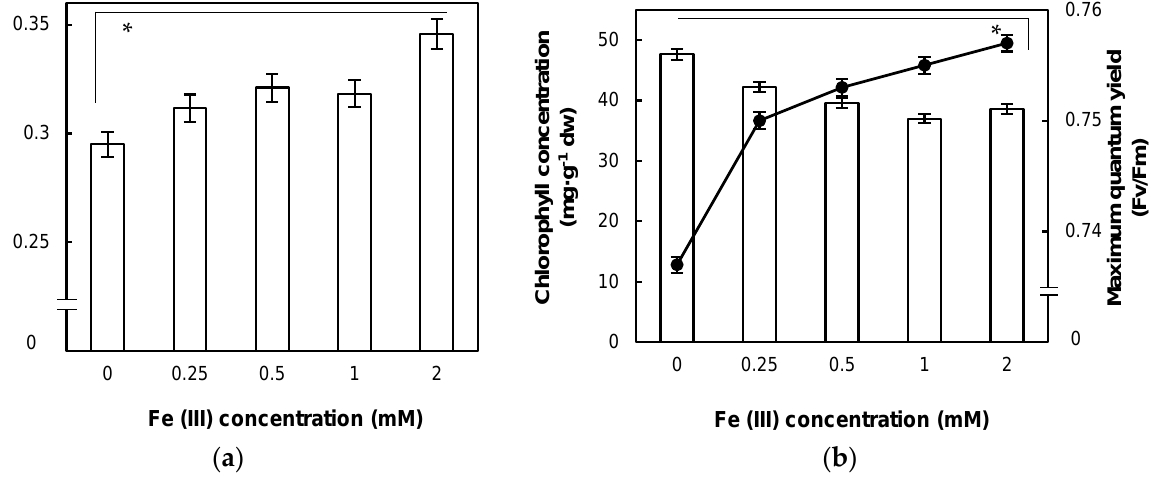
Figure 3. ( a ) Microalgal productivity, ( b ) intracellular chlorophyll concentration (bars) and maximal photosynthetic efficiency of photosystem II (Quantum yield, solid circles), data corresponding to day 4 of cultivation, as a function of the Fe (III) concentration in cultures of the microalga C. onubensis . (*) Represents the significant differences of all treatments with respect to the control cultures with 95% confidence.